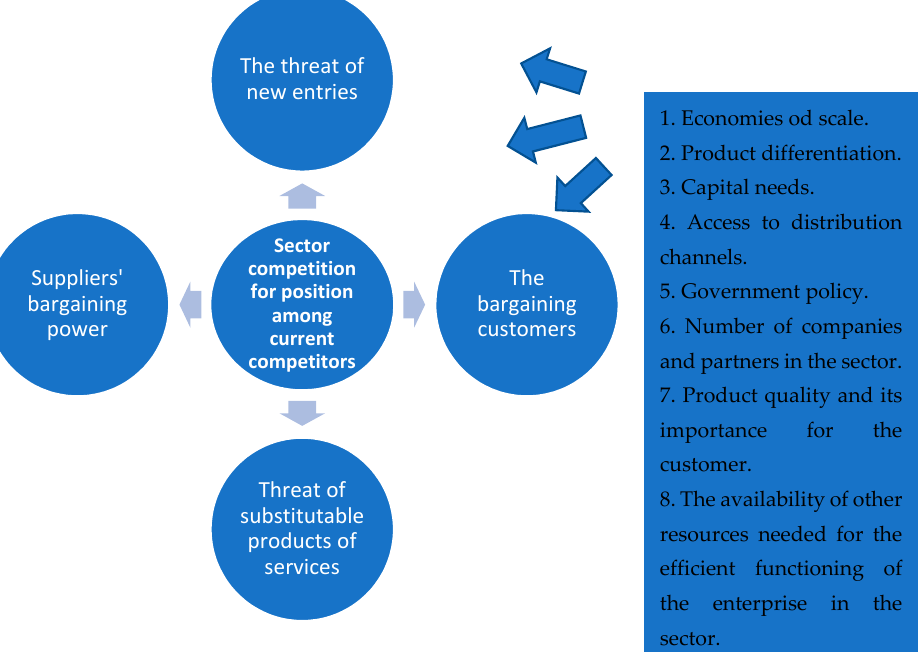
Figure 1. Diagram of Porter’s five forces. Source: own work based on [10].